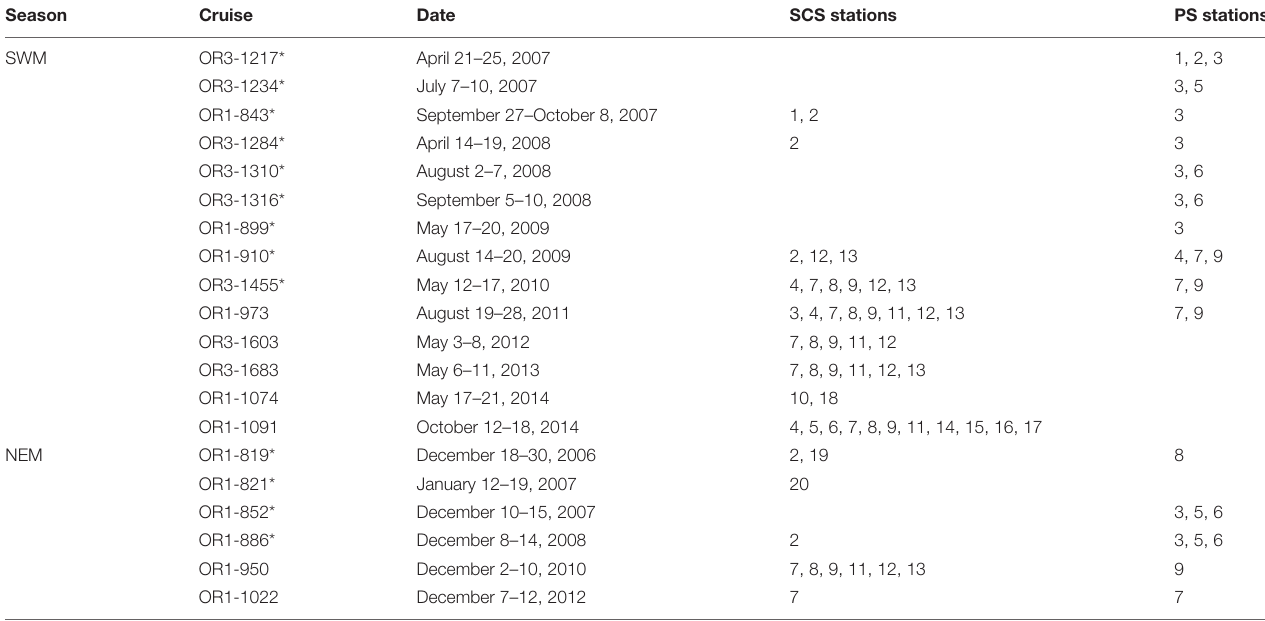
TABLE 1 | Sampling stations occupied during 20 cruises in the SCS and the PS (see Figure 1 for station locations).